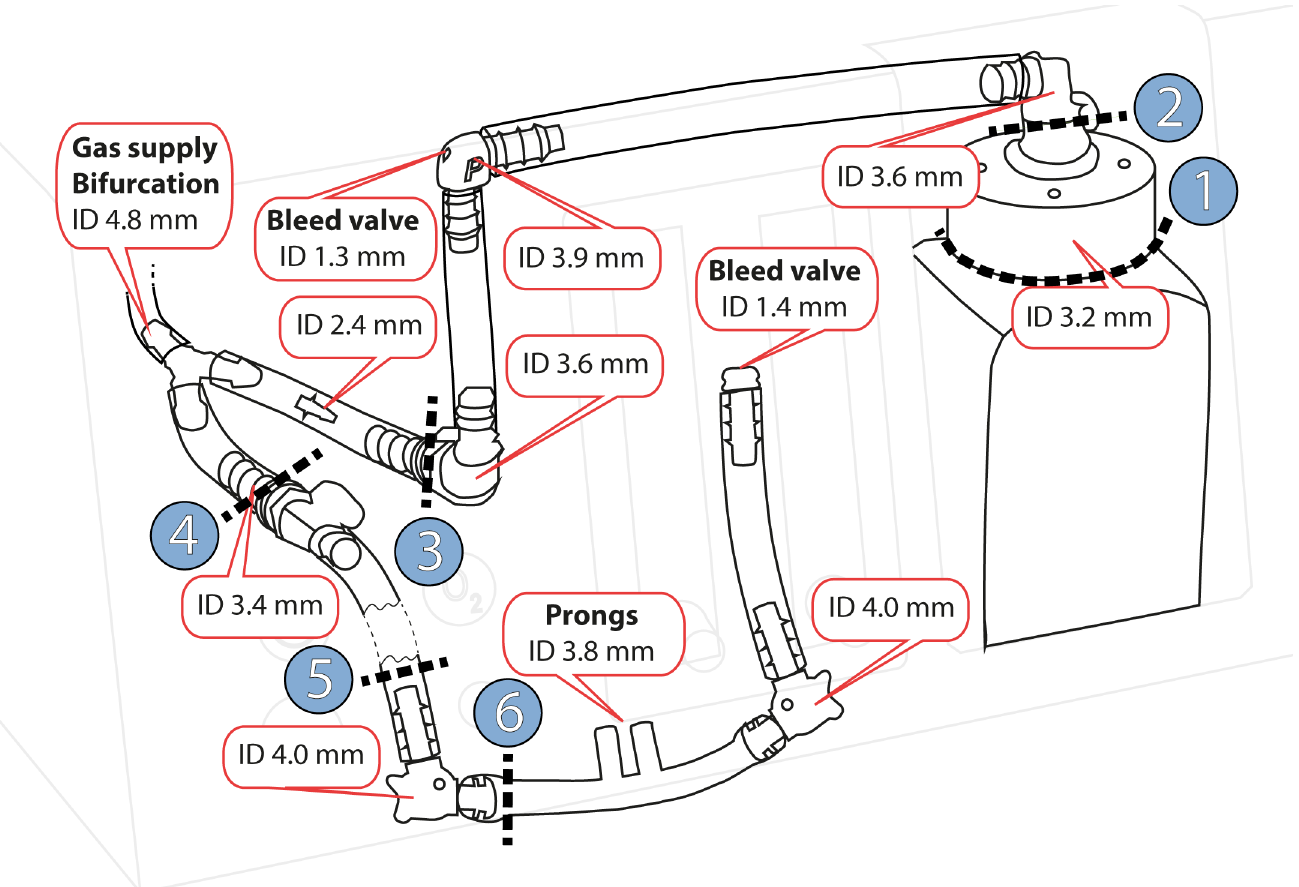
Fig 2. Design and dimensions of the revised Pumani. Fresh gas flow is supplied to the breathing circuit at the bifurcation. The patient is connected to the prongs and gas can leave the system through leakage at the patient, the two bleed ports and at the bubble bottle (right side). Internal diameters (ID) were estimated by the authors. Blue circle 1–6 indicate cutpoints used to determine tube resistance. A simplified illustration of the revised Pumani components is provided in Fig 1